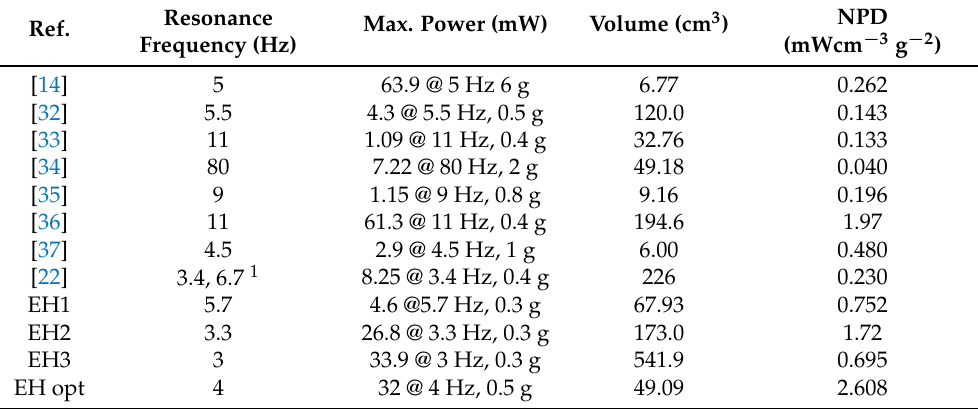
Table 10. Normalized power density of different